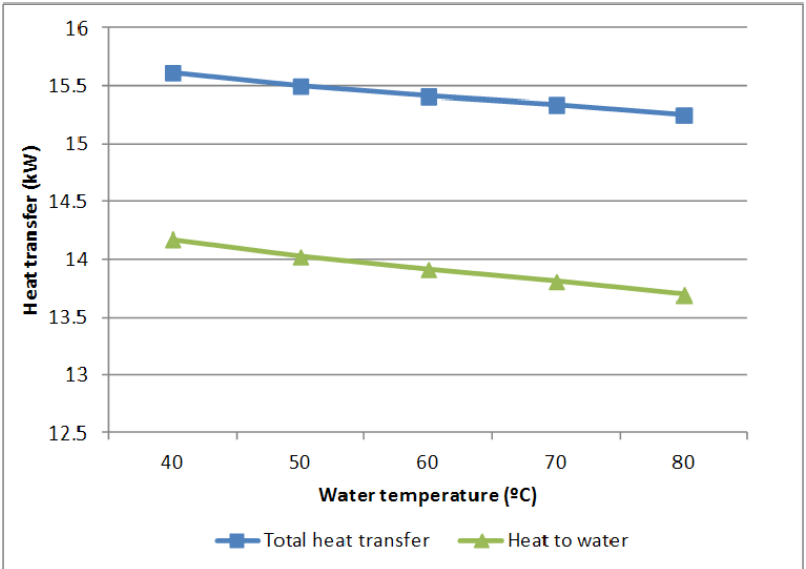
Figure 6. Total heat transfer and heat transfer to water (kW).